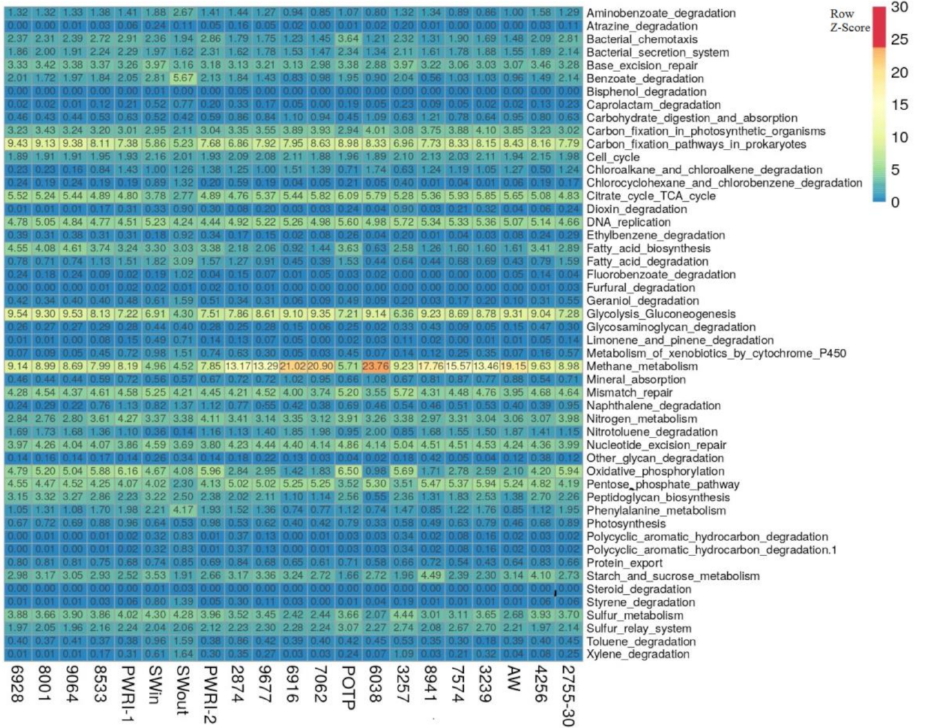
Figure 4. The heatmap showing the clustering of injection and production water samples from the Uzen oil field based on the relative percentage of iVikodak-derived microbial community func- tional